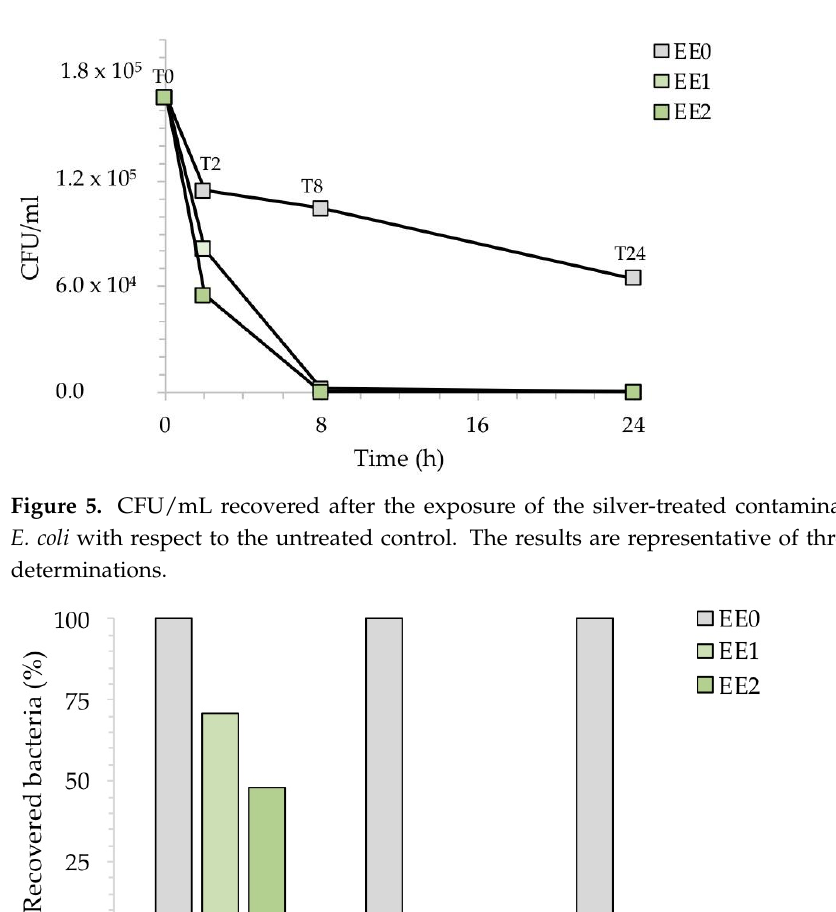
Figure 5. CFU/mL recovered after the exposure of the silver-treated contaminated surfaces to E. coli